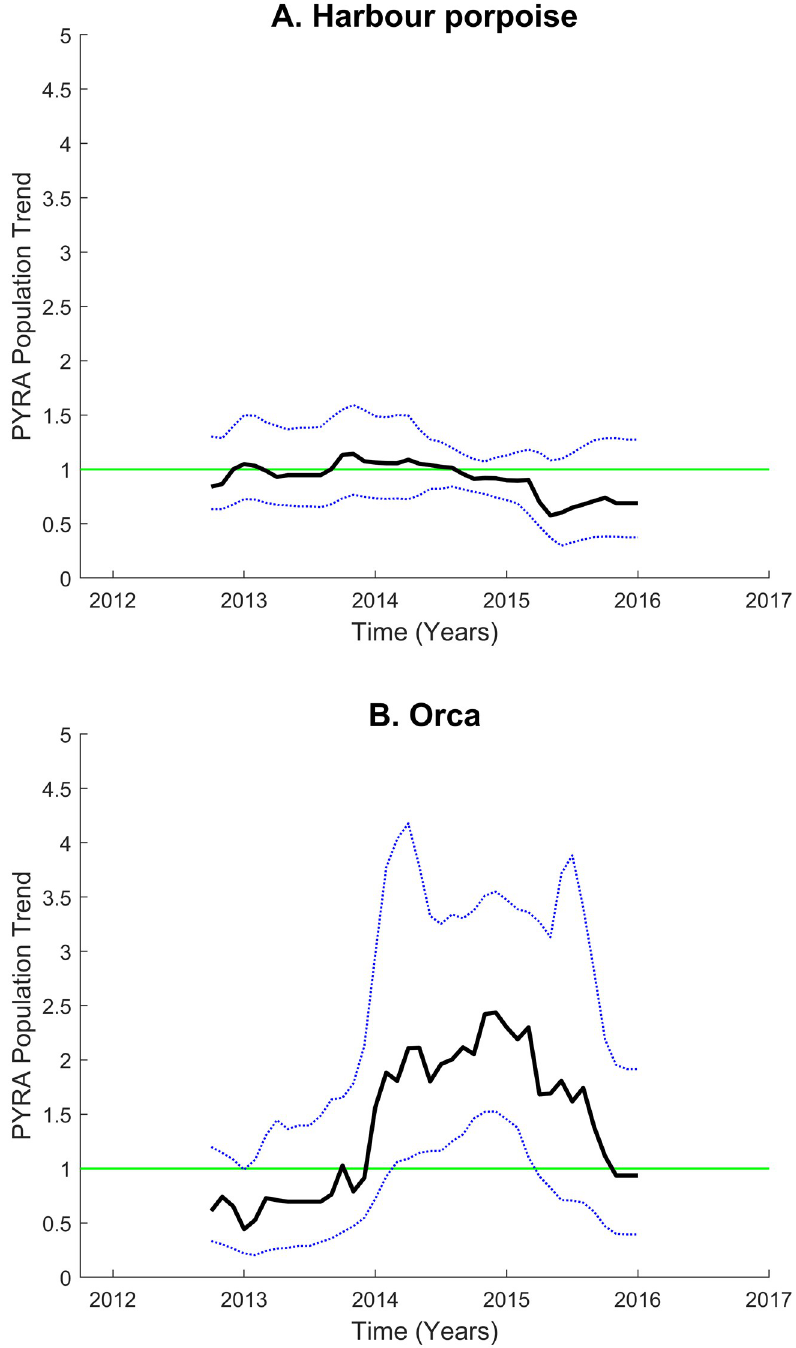
Fig 5. PYRA population trend plots showing c P ð t � Þ against time (solid black) with 95% percentile lower (L) and C upper (U) confidence limits (dotted blue) computed with a sliding bootstrap window of width w = 3 months (90 days) over the time span T of the Salish Sea data set for harbour porpoises (A) and orcas (B). The baseline ‘no trend’ PYRA value of 1 is the horizontal green line. (A) harbour porpoises show a recent downward tendency, the trend statistic c P ¼ 0 : 928 (L = 0.886, U = 0.990) indicates an overall downward trend. (B) orcas show an upward followed by recent T ¼ 1 : 189 (L = 0.962, U = 1.433) indicates an overall upward trend but with downward fluctuation, the trend statistic c P T high uncertainty.